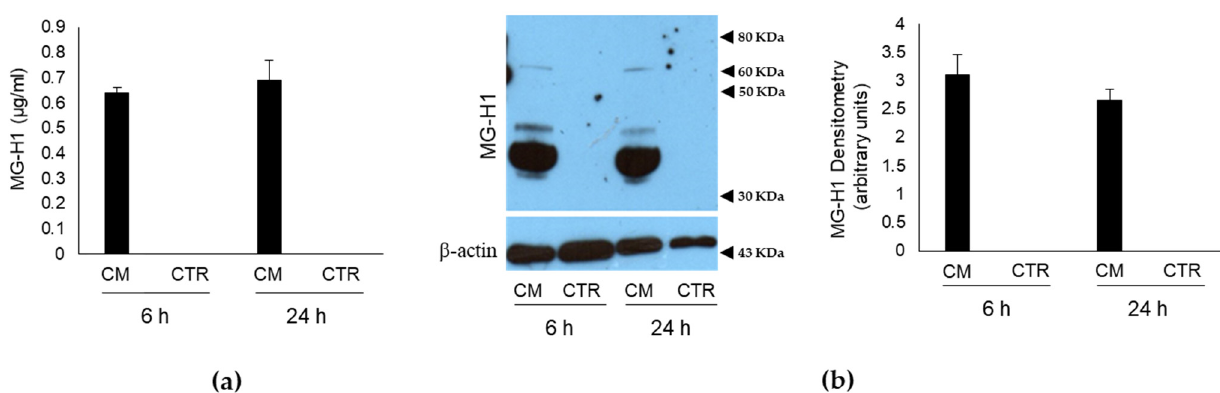
Figure 1. Level of methylglyoxal (MG)-derived 5-hydro-5-methylimidazolone (MG-H1) in the conditioned medium (CM) from PC3 bone metastasis-derived prostate cancer (PCa) cells. MG-H1 levels were measured by ( a ) a specific ELISA kit and ( b ) Western blot. In particular, PC3 were cultured for 6 and 24 h in a humidified atmosphere at 37 °C, and the culture medium they grew in (CM) was used to determine the levels of MG-H1. As a control (CTR), the levels of MG-H1 were also evaluated in the CM, where OB was cultured for the same period of time. β -actin was used as internal control, in agreement with Kwon et al. [25]. The histograms indicate the mean ± SD of three different cultures, and each was tested in duplicate.